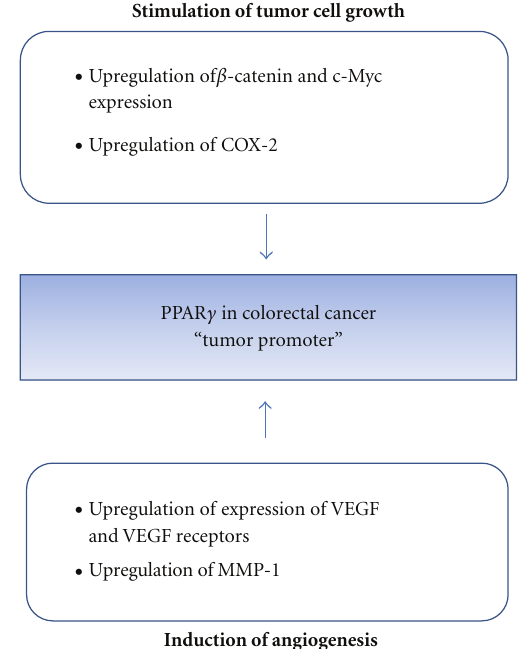
Figure 3: Potential molecular mechanisms for PPAR γ as tumor promoter in colorectal